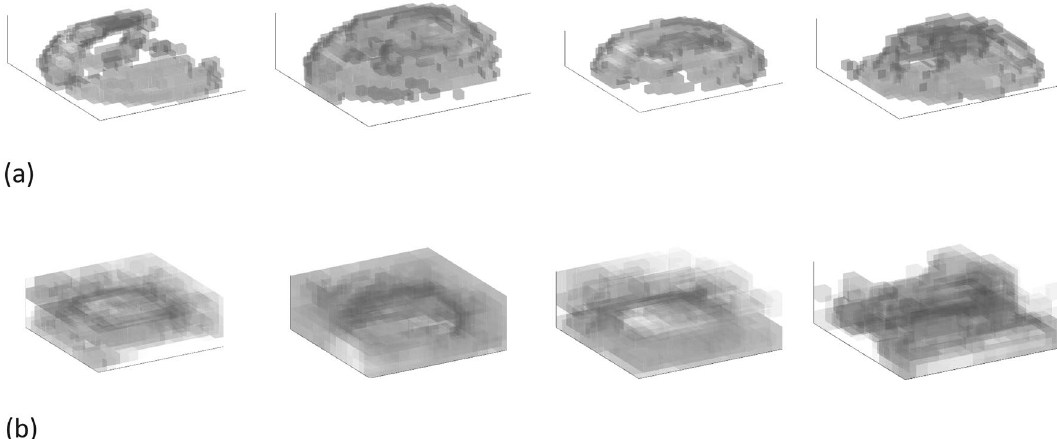
Figure 5. Visualization of typical 3D feature maps before and after the four dilation layers. Detailed input and output datasets are presented in the Supplementary Material. ( a ) The 3D feature maps generated after the encoder and before the dilation layers. Each map is with a volumetric resolution of 28 × 28 × 10. ( b ) The 3D feature maps generated after the four dilation layers and before the decoder layers. Each map is with a volumetric resolution of 14 × 14 ×